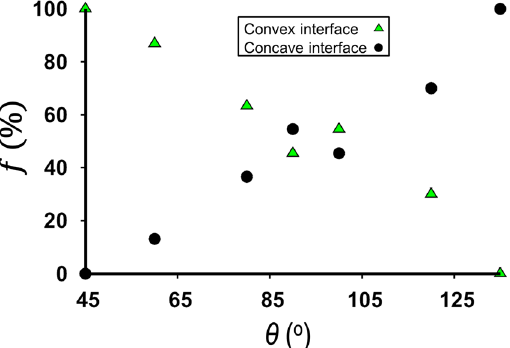
Figure 4. Fraction 𝑓 (%) of concave and convex interfaces when the displacement front is approximately 8 mm away from the intlet. Overall, the fraction of concave interface increases while the fraction of convex interfaces decreases as θ is increased from 45° to 135°. In the range of θ between 60° and 120°, substantial co-existence of concave and convex interfaces